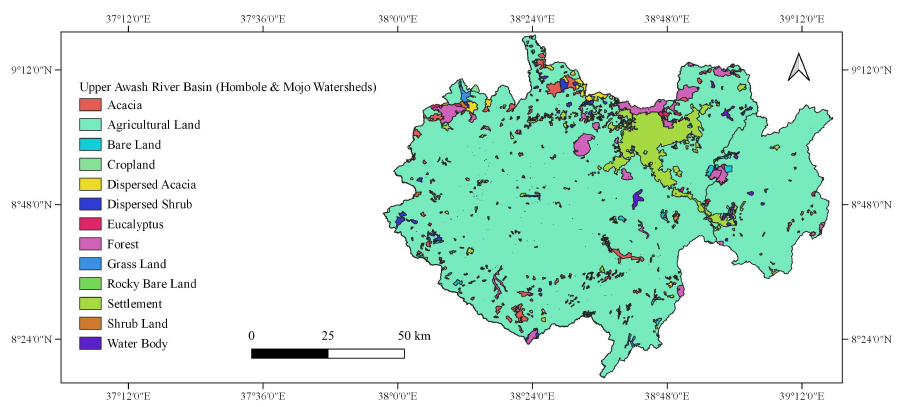
Figure A7. Land use map of Upper Awash River Basin (Hombole and Mojo watersheds) from 2013 to 2015.